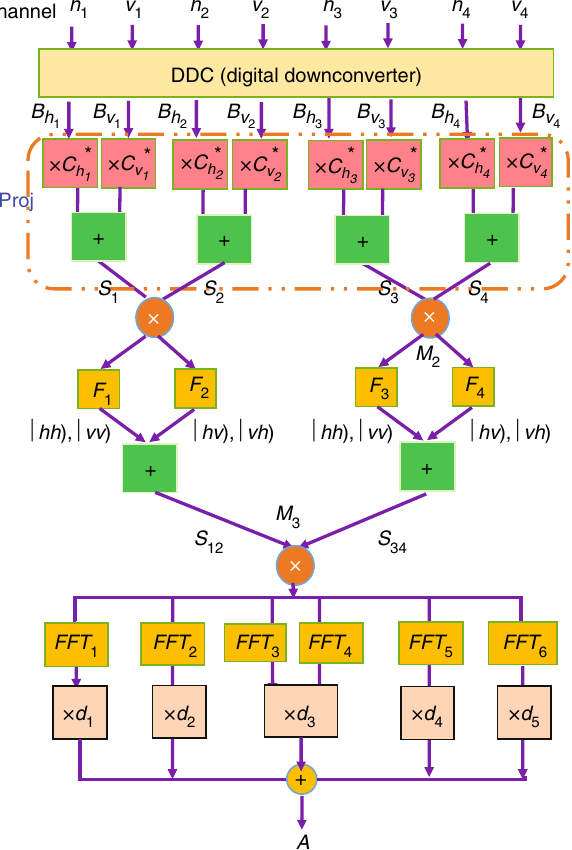
Fig. 4 The designed work fl ow to obtain the classical analogy of the state | Ξ 〉 4 in the DSP module. All eight signals in the channels { h 1 , v 1 , … , h 4 , v 4 } fed into the DSP are digitally down-converted to their own frequencies as planned. After a measuring process through the PROJ part followed by several mixing and fi ltering processes for multiplex signals, the desired frequency components selected by a collections of FFT-based digital fi lters { FFT 1 , … , FFT 6 } are adjusted by fi ve modulators { d 1 , … , d 5 }, respectively, and